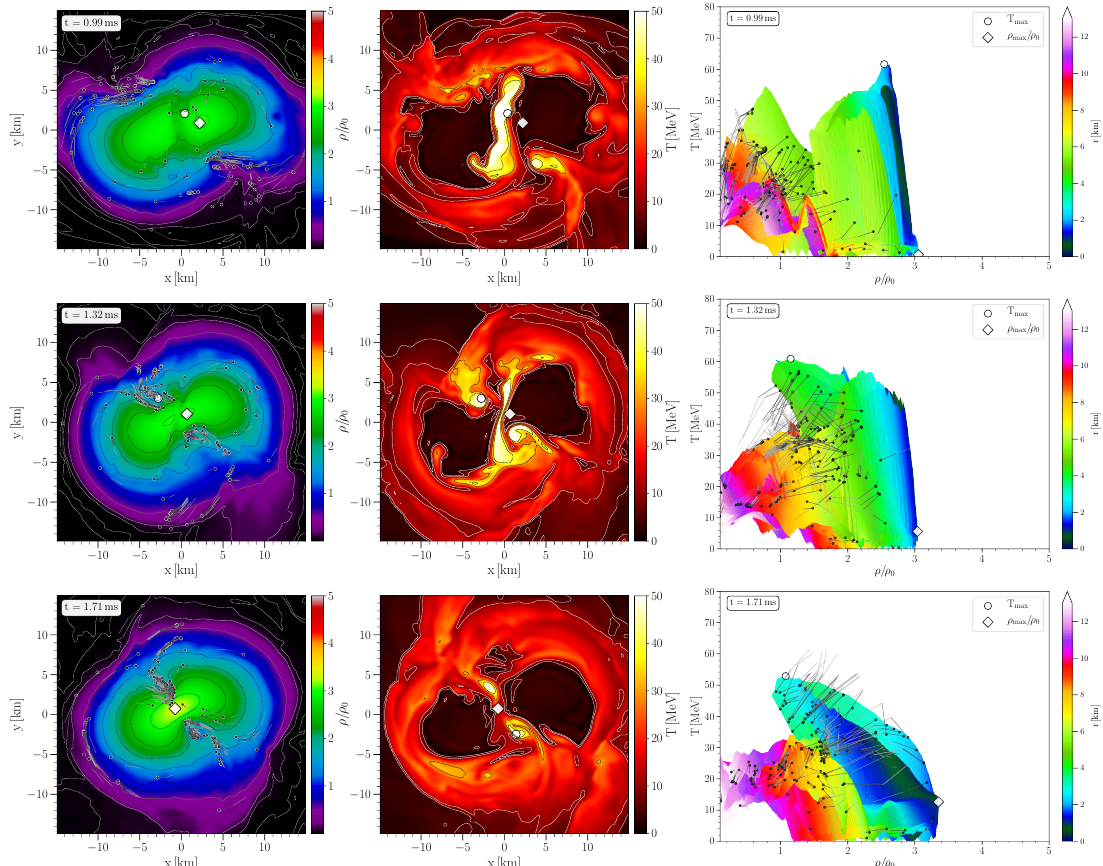
Figure 2. Same as Figure 1 but for later time snapshots within the early post-merger phase.